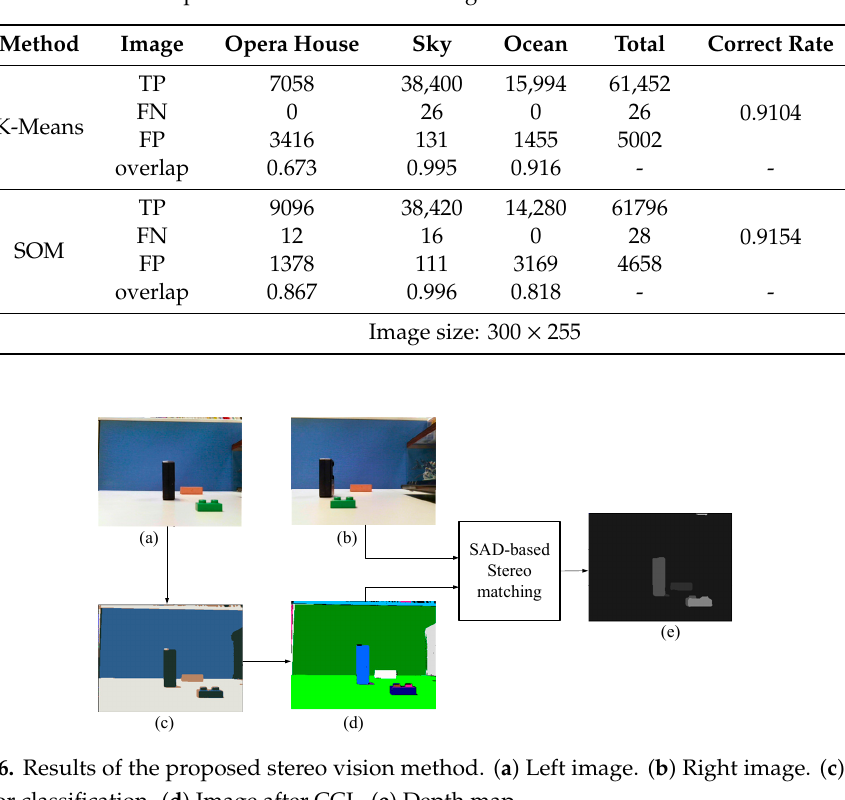
Table 1. Comparison of k-means clustering and the SOM neural network.